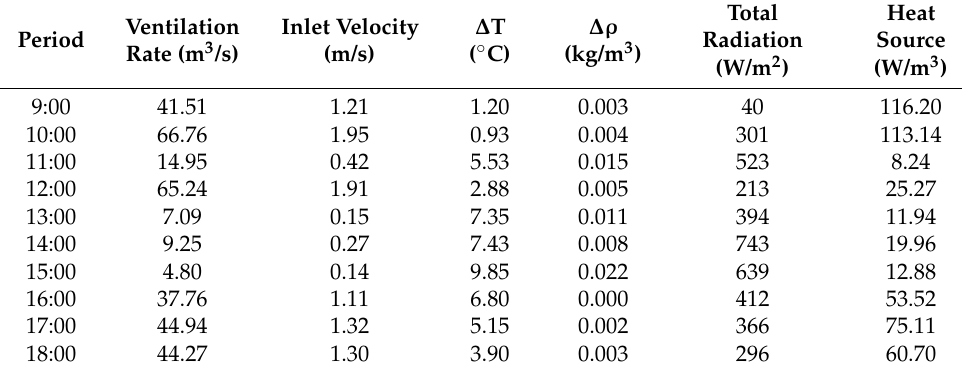
Table 6. Values calculated for ventilation − rate − related factors.